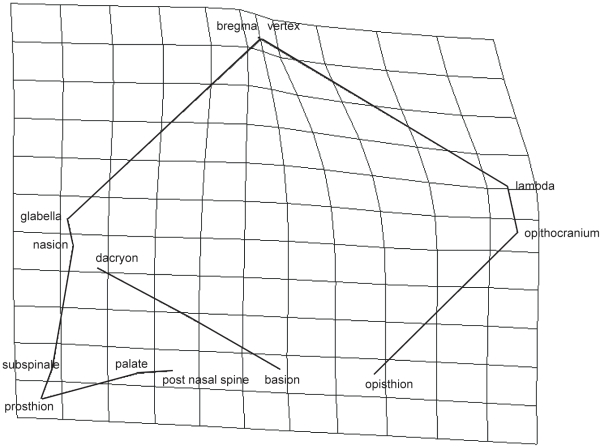
Transformation grids on PC2 in lateral (A) view.Non-pygmies were considered the reference and Pygmies, the target. Frontal and basilar views do not represent any important variation.